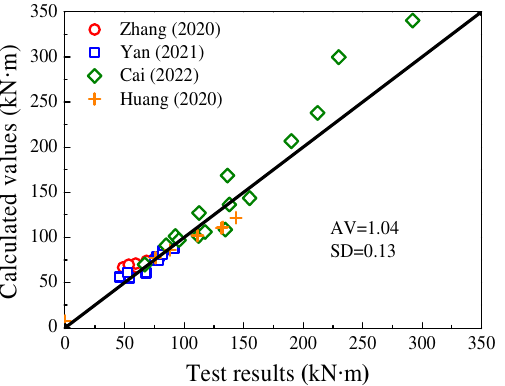
Test results ( kN . m ) Figure 19. The comparison of predicted moment-bearing capacities with test results. (Zhang et al. [35], Huang et al. [36], Cai [38], Yan et al.